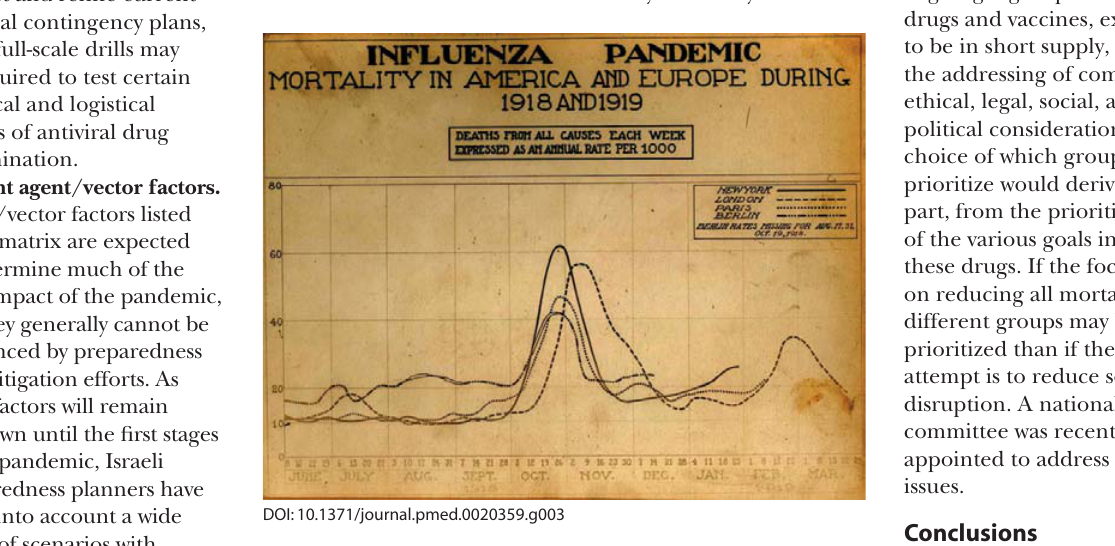
Figure 3. Historic Chart Showing Mortality Rates in America and Europe during 1918 and 1919 (Photo: Image “Reeve 3143,” National Museum of Health and Medicine, Armed Forces Institute of Pathology, Washington,